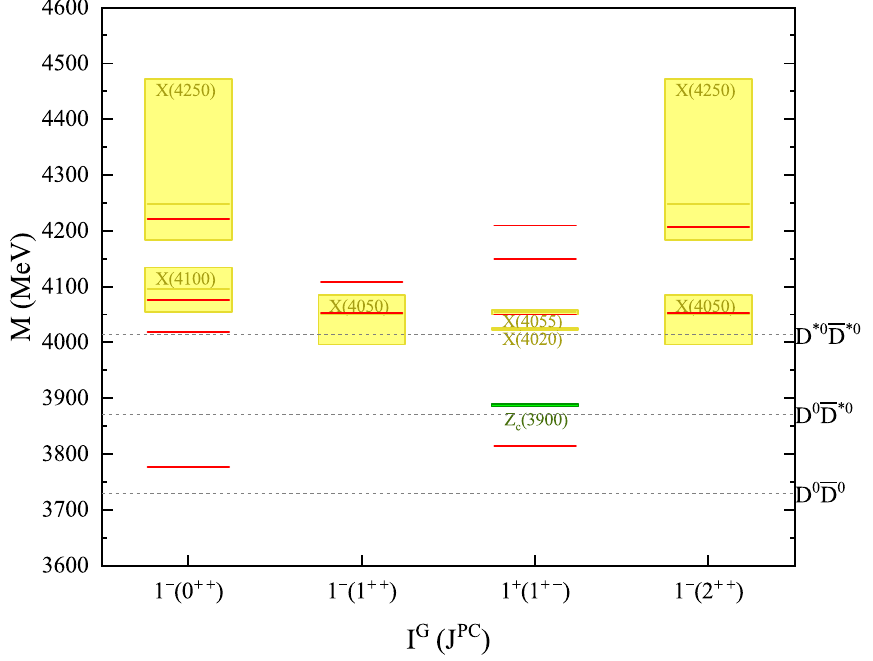
Fig. 2 Massspectraofground S -wave Z c states.Redsolidlinesdenote the model results. Gray dotted lines are corresponding S -wave charm meson pair thresholds. The green rectangle represents experimental mass of Z c ( 3900 ) with definite quantum number, the rectangle width is its mass uncertainty. The yellow rectangles represents the electric charmonium-like states, observed in experiments near 4.1 GeV, whose